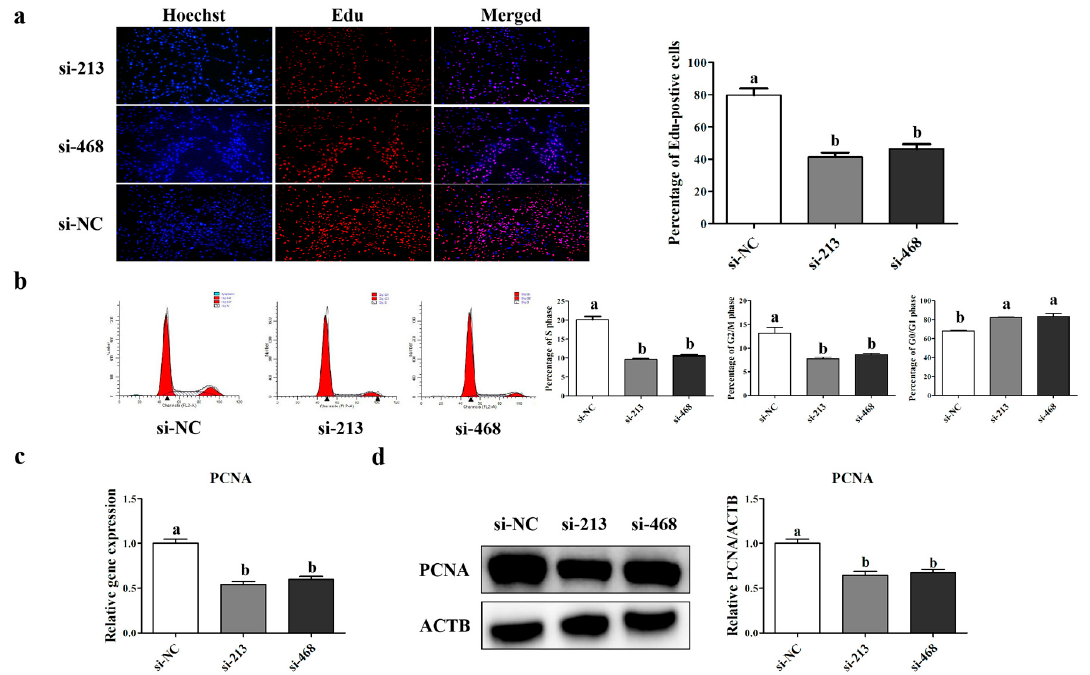
Figure 6. Cell proliferation was determined using EDU after transfection with si-213, si-468, and si-NC ( a ). Nuclear stain Hoechst (blue) and the proliferating cell stain EDU (red). The e ff ect of siRNA transfection on the cell cycle progression in myoblasts ( b ). DNA content levels are also represented (b). The expression level of proliferating cell nuclear antigen ( PCNA ) mRNA ( c ) and protein ( d ) was measured by qRT-PCR and Western blot. The expression of genes and proteins was normalized to β -actin ( ACTB ) and related to si-NC. a, b, c: di ff erent letters denote statistically significant di ff erences within each group; p < 0.05.